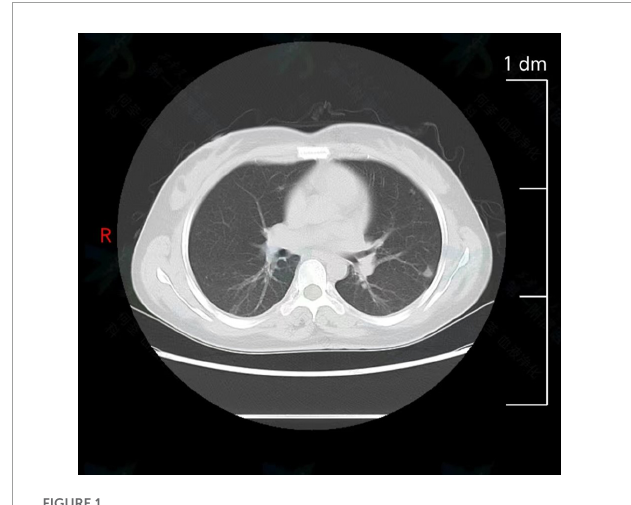
FIGURE1 Chest computed tomography (CT) revealed multiple pulmonary nodules in both